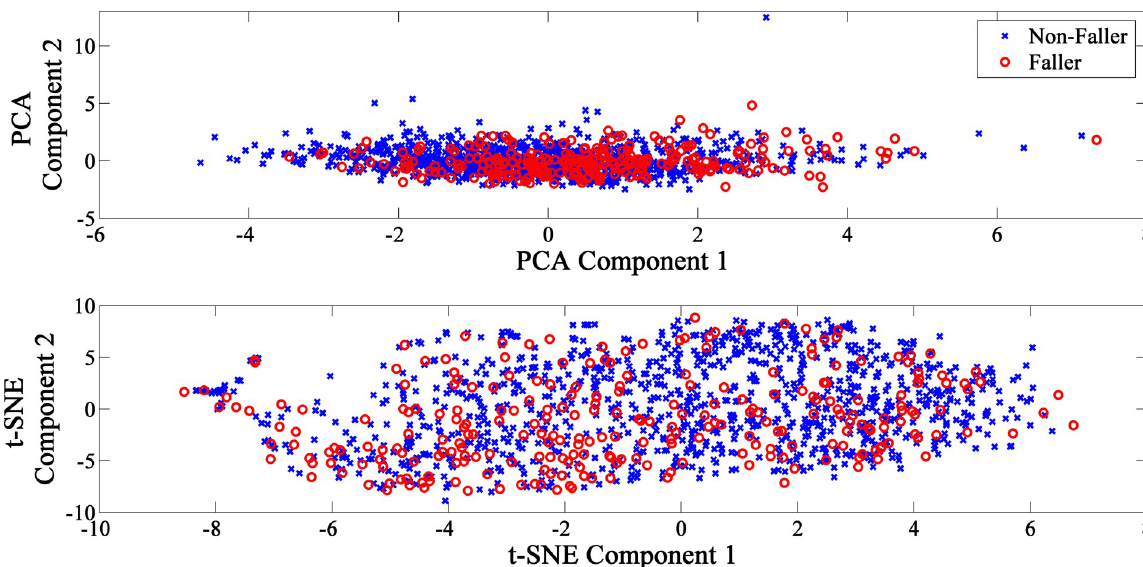
Fig 2. The first two components extracted from the feature extraction algorithm. (top) PCA feature extraction; (bottom) t-SNE feature extraction.